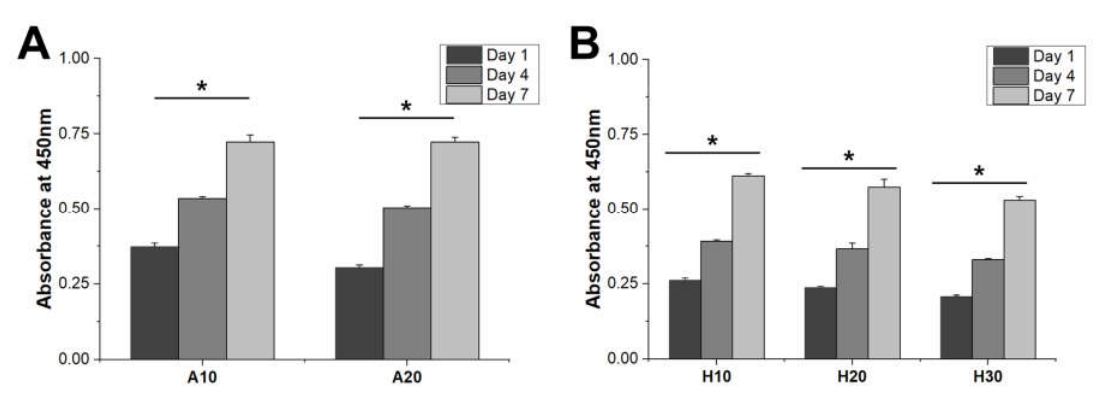
Figure 6. Biocompatibility of the SF scaffold. Initial cell attachment on the ( A ) aqueous and ( B ) HFIP-based SF scaffolds. All scaffolds revealed similar proliferation rates. Cell proliferation occurred in all groups at similar rates. Cell adhesion decreased in all groups with increasing SF concentration. Higher cell adhesion was observed in the aqueous-based SF scaffolds compared to the HFIP-based SF scaffolds (* p < 0.005).